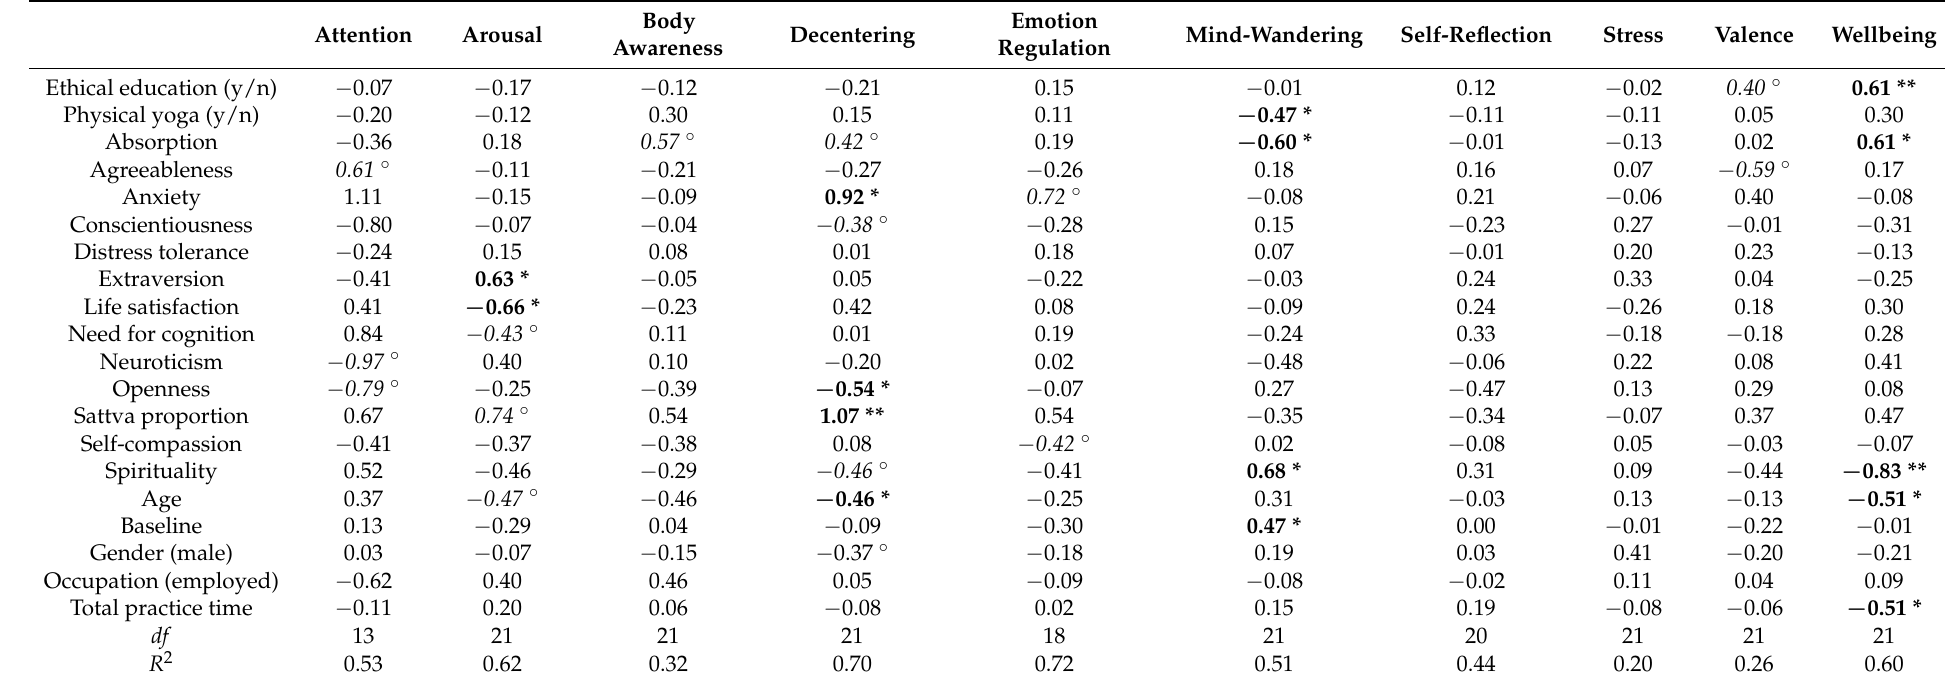
Table 2. Standardised regression estimates of all predictor variables on all dependent variables. Body Emotion Attention Arousal Decentering Mind-Wandering Self-Reflection Stress Valence Awareness Regulation